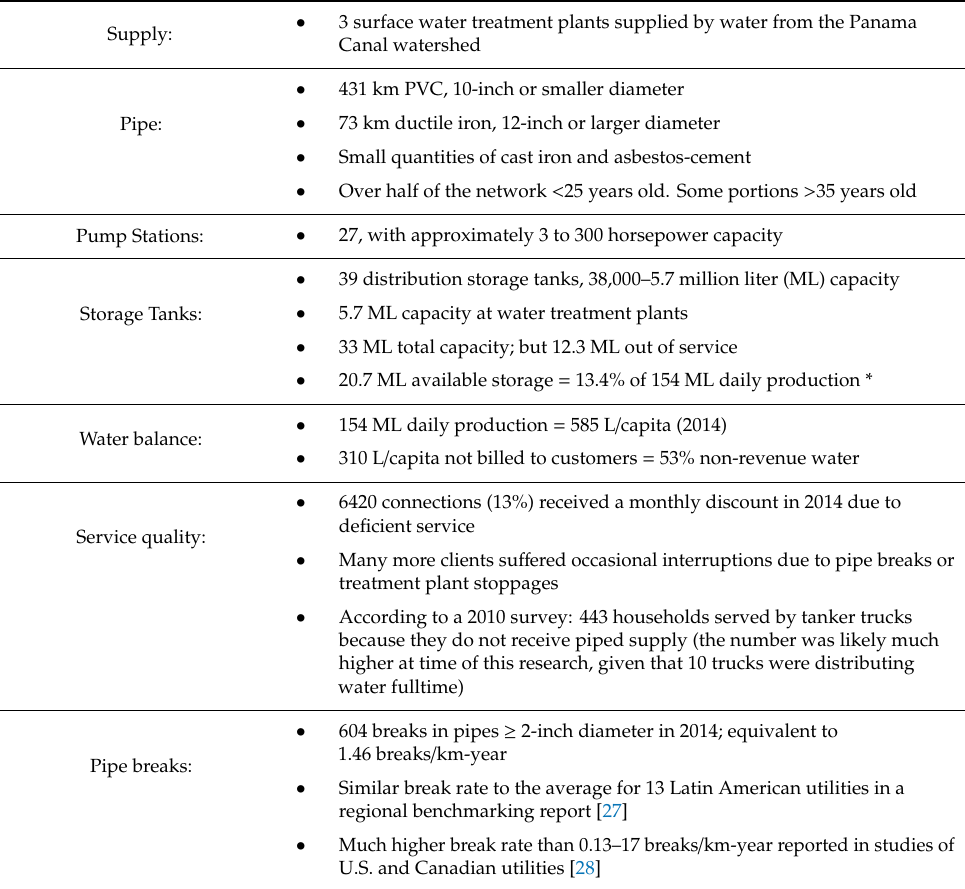
Table 1. Arraiján Distribution System Vital Statistics (from [26] and interviews with IDAAN personnel).